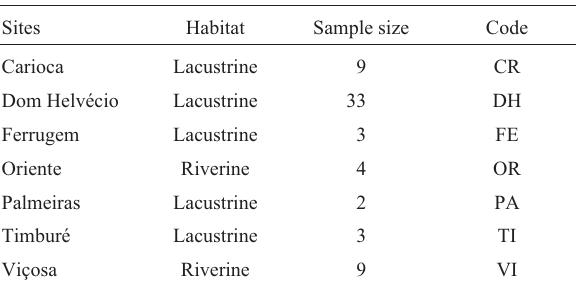
Table I - Sites and sample sizes of Hoplias malabaricus in the Rio Doce